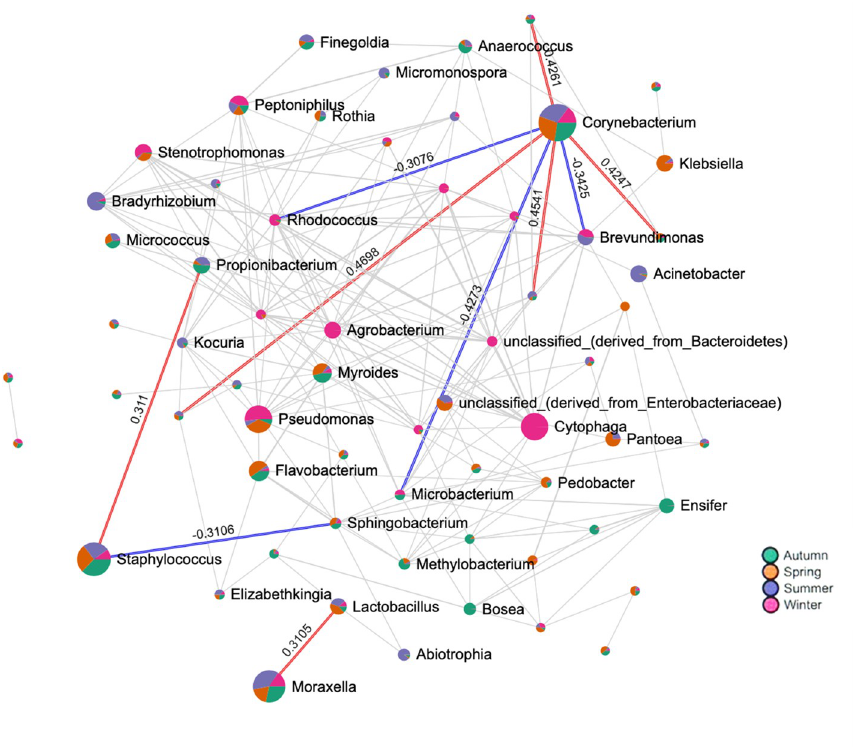
Fig 7. A network analysis of nasal bacterial genera of health care professionals of a clinical research laboratory. The figure shows networks between abundant sequences at the genus level built from SparCC correlation coefficients. Each node represents a bacterial genus and the edges represent the correlation coefficients between the genera. Blue edges are negative correlations and red edges mean positive correlations. The values on the edges signify the correlation coefficients. Nodes are colored according to the season (Green-Autumn; Orange-Spring; Blue-Summer;